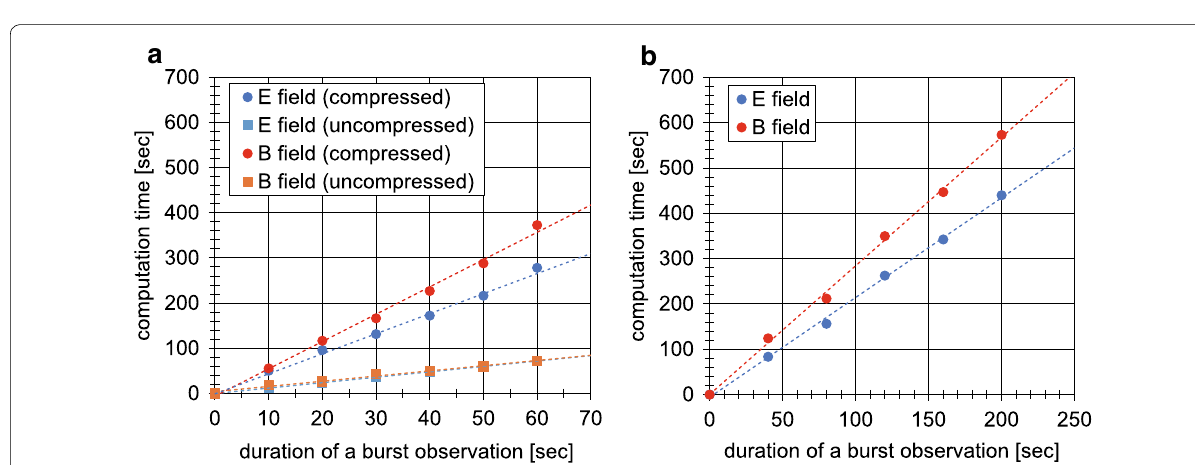
Fig. 12 Performances of the burst-mode data processing. a Chorus burst mode, b EMIC burst